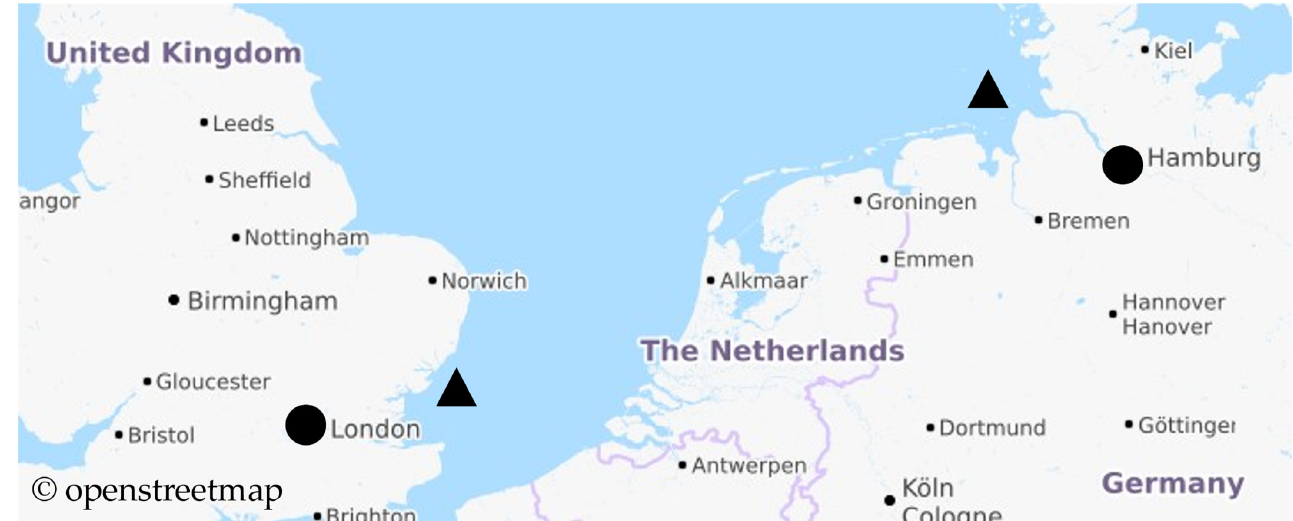
Figure 1. Assumed locations in Germany and the United Kingdom [42].